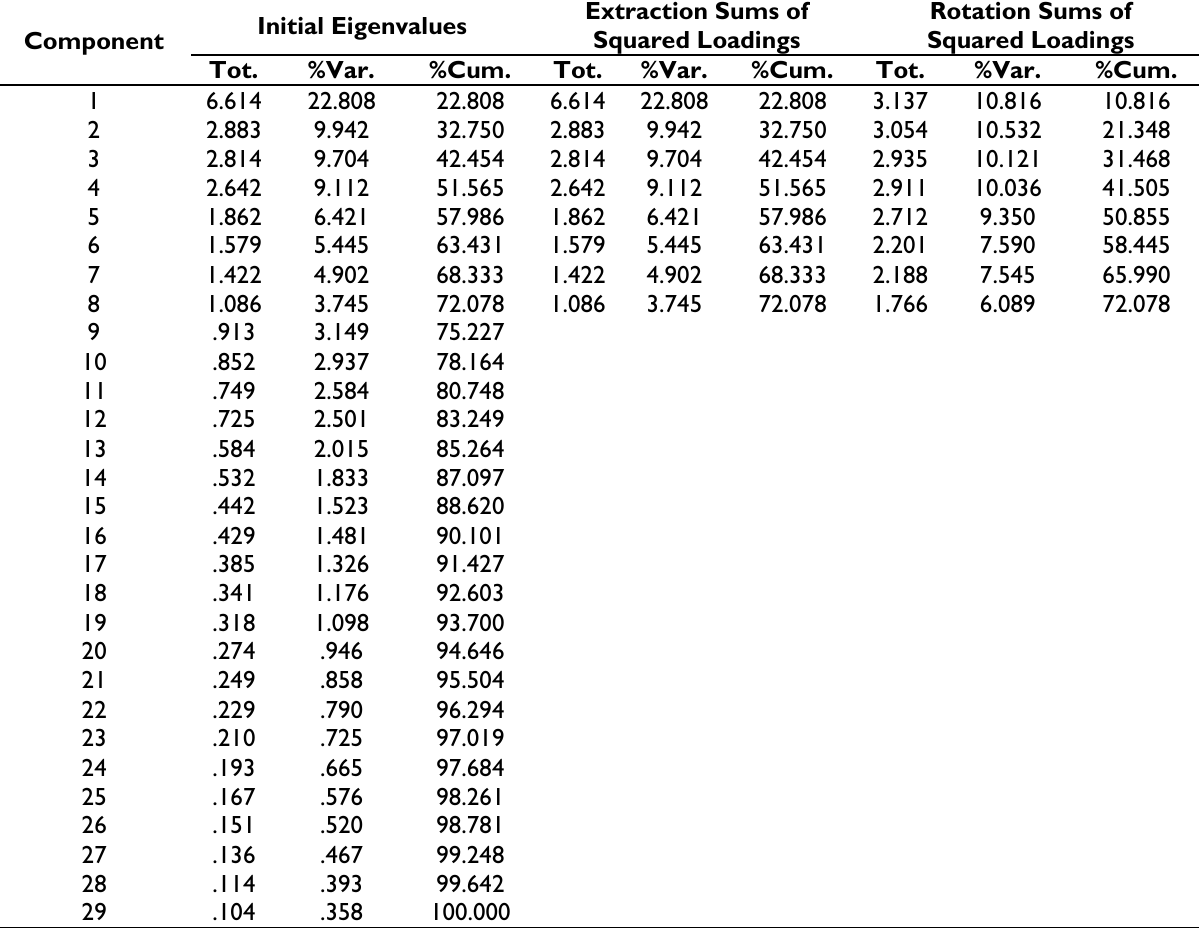
Table 2: Total Variance